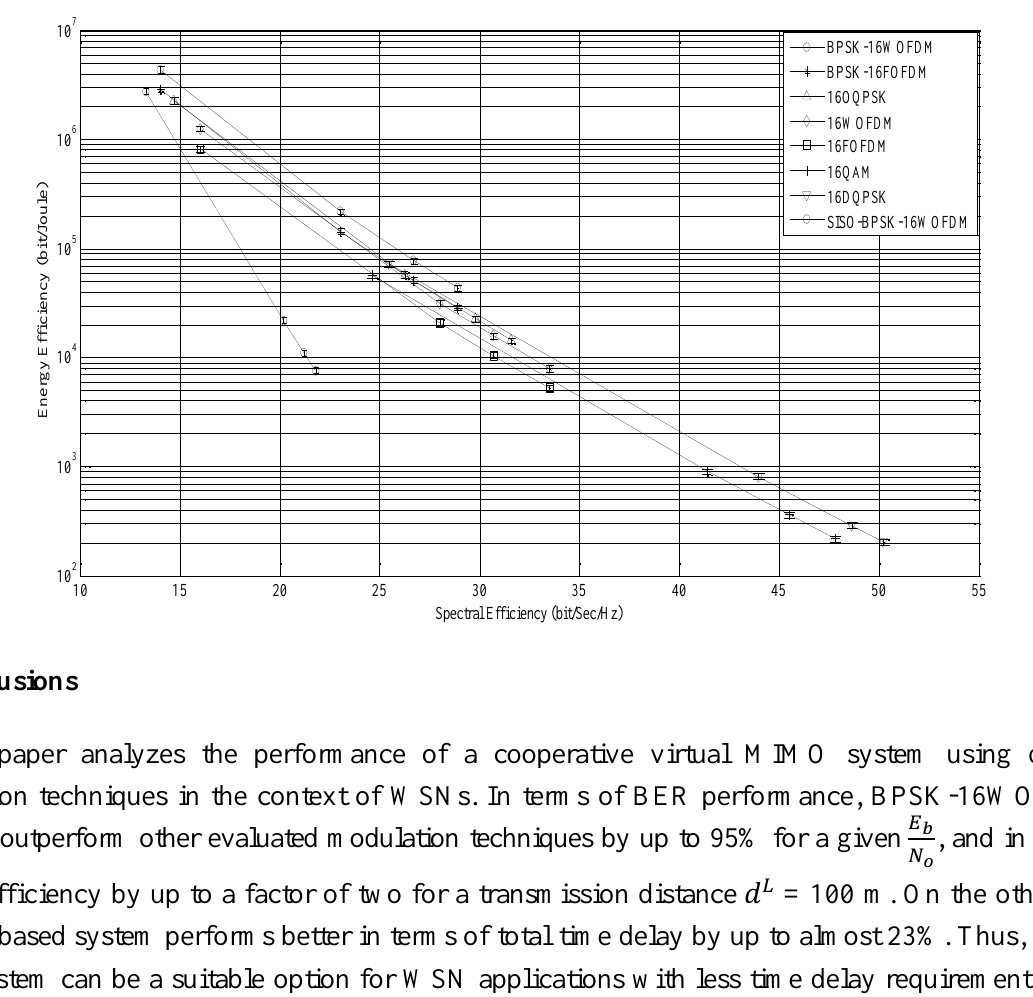
Figure 9. Energy efficiency vs. Spectral efficiency over transmission distance = 20